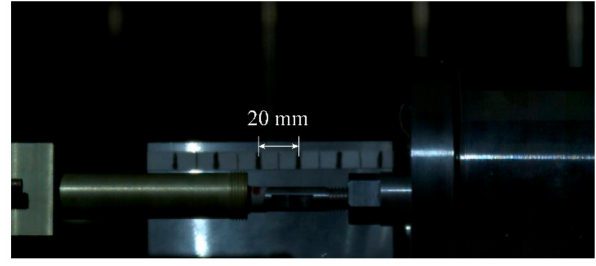
Figure 17. Distance marking in the test of the aluminum honeycomb type of measuring device.